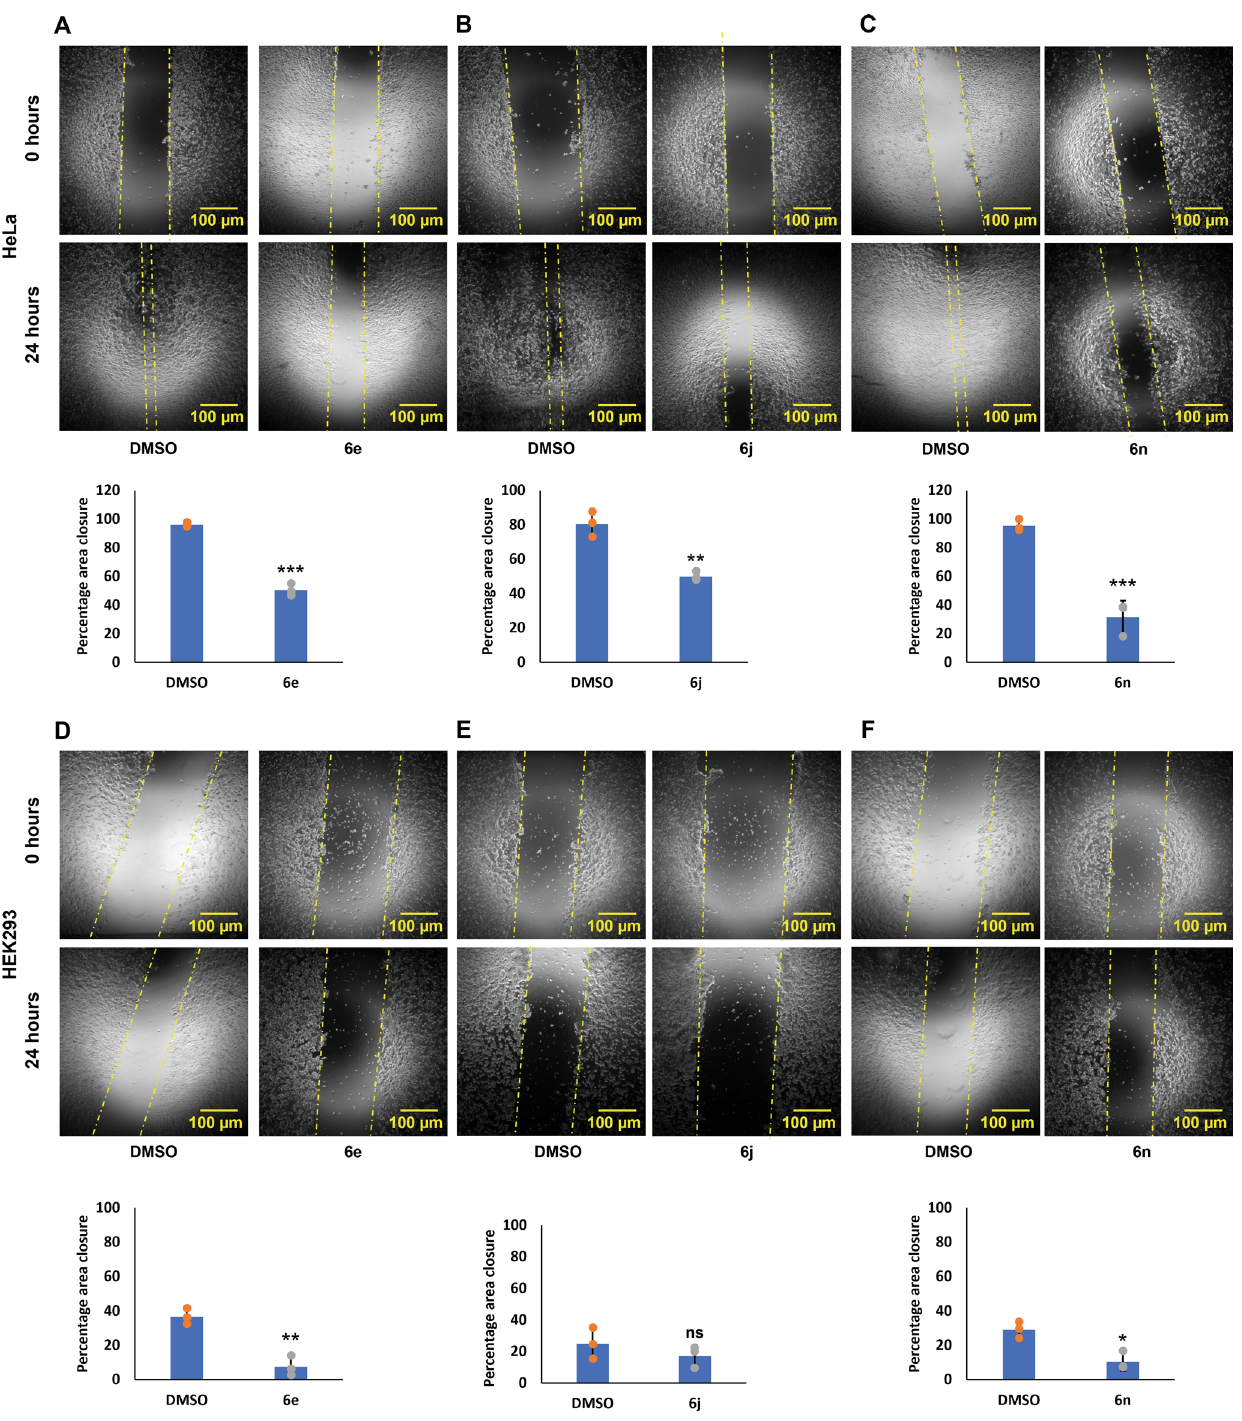
Fig. 8 Effect of cATC derivatives on cell migration. Wound healing assay was done in HeLa and HEK293 cells treated with 6e (18 μ M), 6j (19.23 μ M), 6n (18.92 μ M), and DMSO, for 24 h. A – C Images of wound at 0 h and 24 h in HeLa cells treated with 6e ( A ), 6j ( B ), and 6n ( C ). Corresponding bar graphs showing percentage of wound area closure in 24 h. D – F Images of wound at 0 h and 24 h in HEK293 cells treated with 6e ( D ), 6j ( E ), and 6n ( F ). Corresponding bar graphs showing percentage of wound area closure in 24 h. N = 3; mean ± SD; two-tailed unpaired Student ’ s t test; ns represents non- signi fi cant, ** represents p -value ≤ 0.01, *** represents p -value ≤ 0.001 and, **** represents p -value ≤ 0.0001, N represents experiment replicates. Scale bar is 100 µ